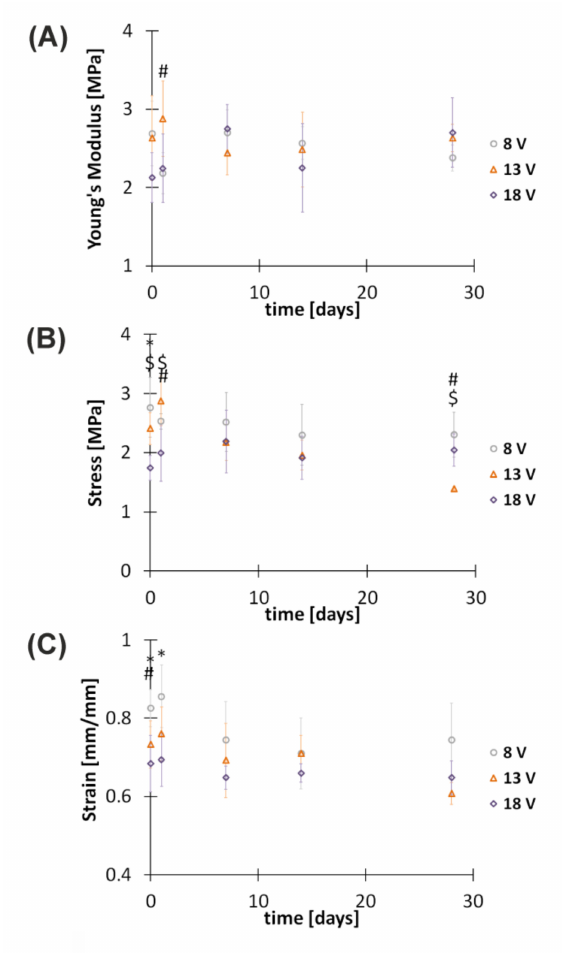
Figure 6. Tensile testing of hybrid implants incubated in PBS (pH 7.4) at 37 ◦ C for specified periods. ( A ) Young’s modulus, ( B ) ultimate stress, and ( C ) ultimate strain. *, #, and $ indicate significant differences between groups of implants obtained in electrodeposition at 8 V and 18 V ( p < 0.05), 8 V and 13 V ( p < 0.05), and 13 V and 18 V ( p < 0.05),